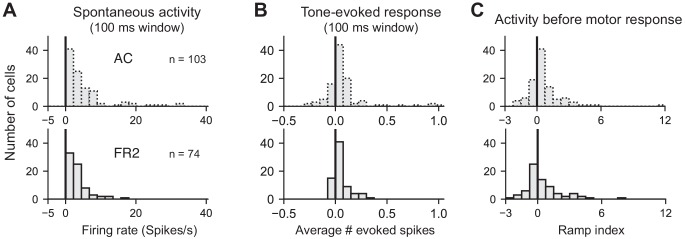
Summary statistics.Histograms of (A) spontaneous firing rate, (B) average number of tone-evoked spikes for preferred stimulus category, and (C) ramp index for AC (top) and FR2 (bottom).